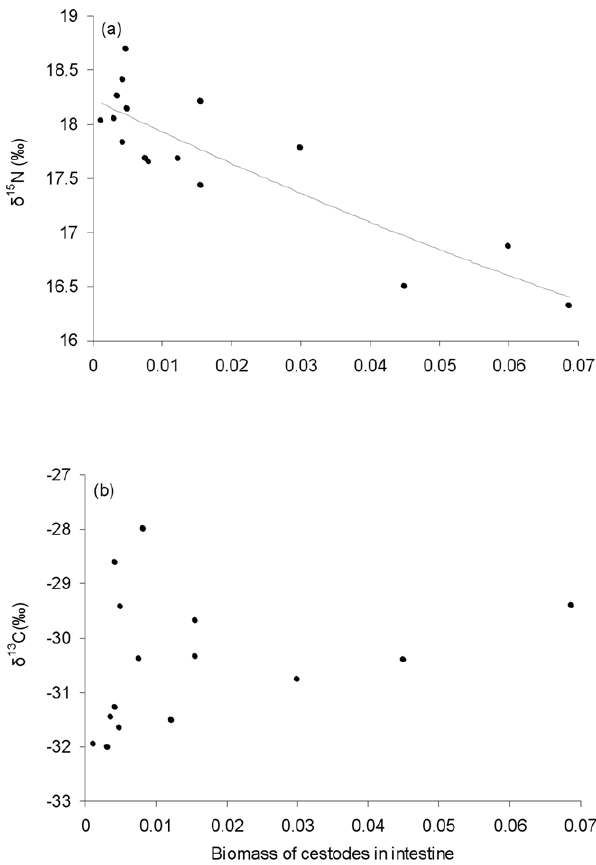
Figure 3. Relationship of (a) d 15 N and (b) d 13 C and parasite burden in Cyprinus carpio parasitized with Bothriocephalus acheilognathi . The solid line represents the significant relationship between d 15 N and parasite burden according to polynomial regression ( cf. Results).